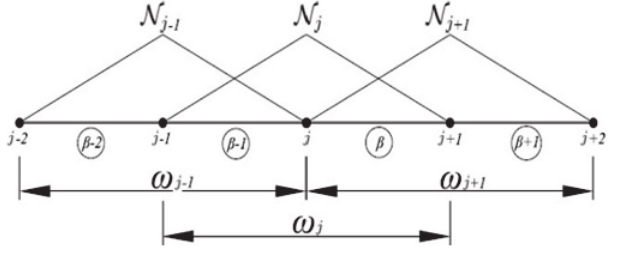
Figure 1 Partition of Unity from finite